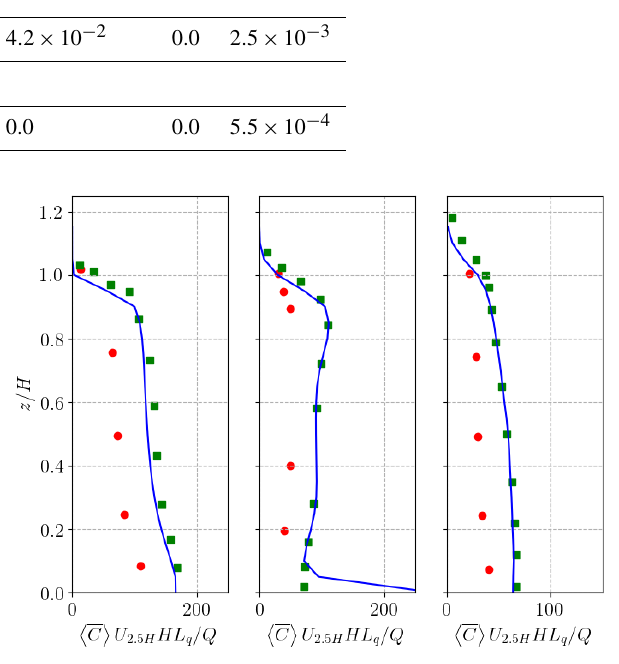
Figure C1. Vertical profiles of the normalised mean concentration plotted at x/W = − 0 . 5, 0 and 0.5. The results from present LES simulations are plotted in blue lines and are compared with wind- tunnel data from Pavageau and Schatzmann (1999) (red circles) and LES data from Michioka et al. (2011) (green squares). U 2 . 5 H de- notes the temporal and spatial average of the streamwise velocity at z/H = 2.5, and Q is the source